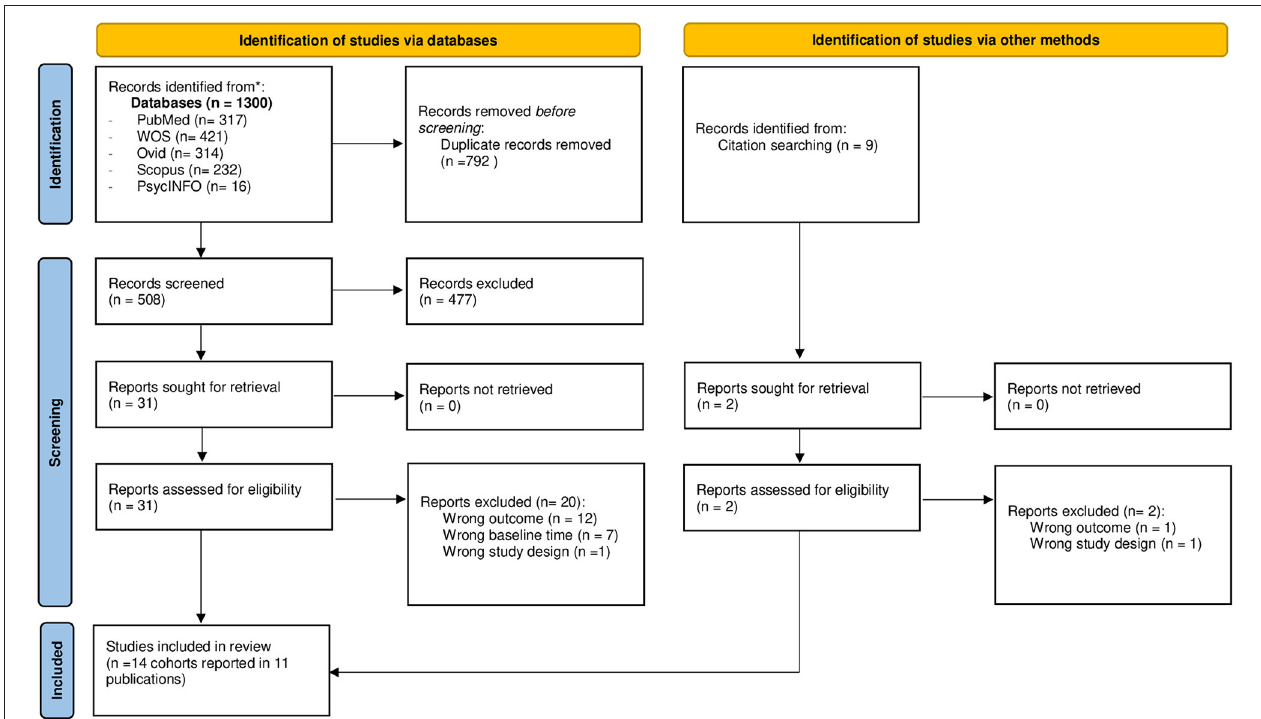
FIGURE 1 | PRISMA 2020 flow diagram of the studies